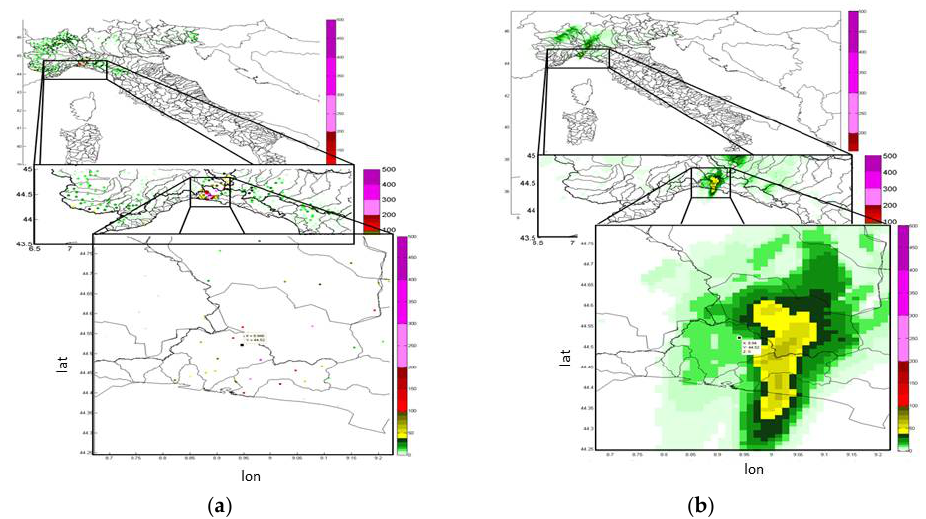
Figure A3. Example of local window domain centered on the rain gauge location ( a ) and on the radar map ( b ). On this area, the correlation is evaluated and the best covariance kernel is identified.